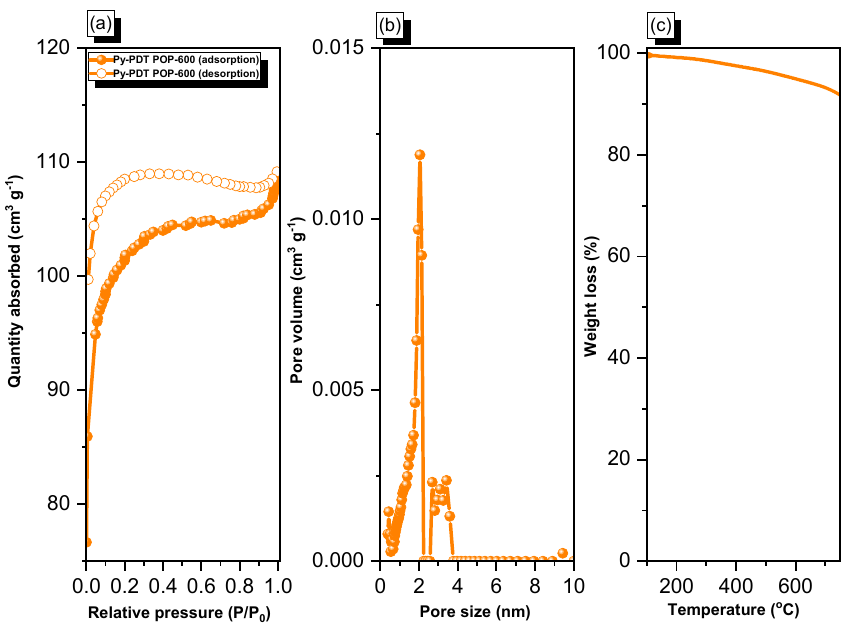
Figure 4. N 2 adsorption/desorption ( a ), pore size (PSD) ( b ), and TGA ( c ) curves of Py-PDT POP-600. SEM and TEM analyses were used to examine the morphology of our porous Py-PDT POP-600. The SEM images of Py-PDT POP-600 revealed an aggregation and sheet structure (Figure 5a,b). SEM-EDS was used to confirm the compositions and different elements in the chemical forms of Py-PDT POP-600. The data showed the presence of C, N, and O atoms distributed in the Py-PDT POP-600 skeleton (Figure 5c–f). Furthermore, the TEM images of Py-PDT POP-600 elucidated the rod-like and microporous structures (Figure 5g–i). As expected, the amorphous forms of both Py-PDT POP and Py-PDT POP-600 were revealed through the XRD